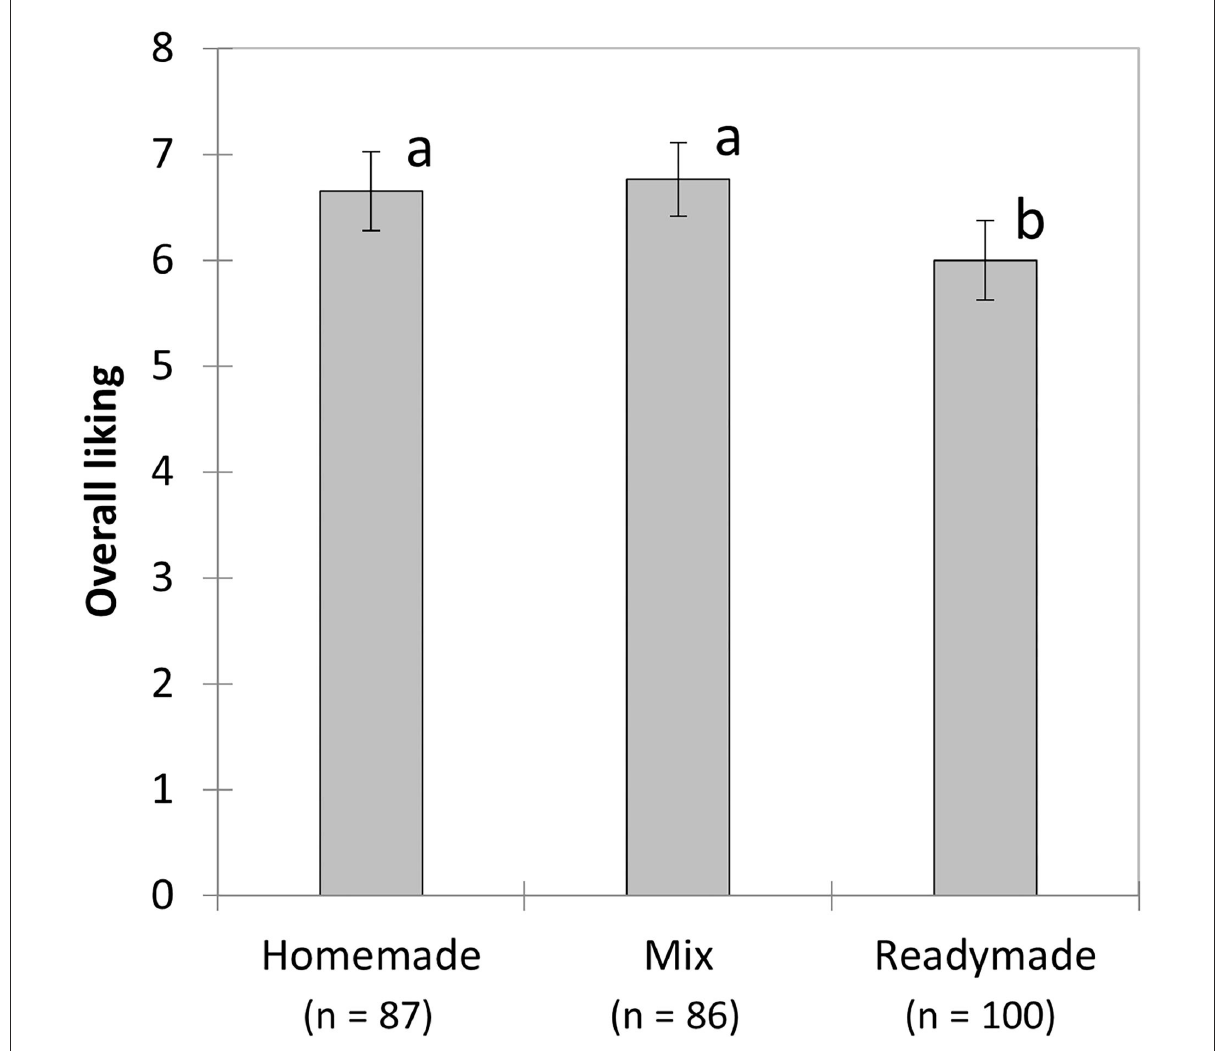
FIGURE2 Mean scores (and SEM) for overall liking of the three pizza preparations. a and b indicate Tukey post-hoc groupings at p <